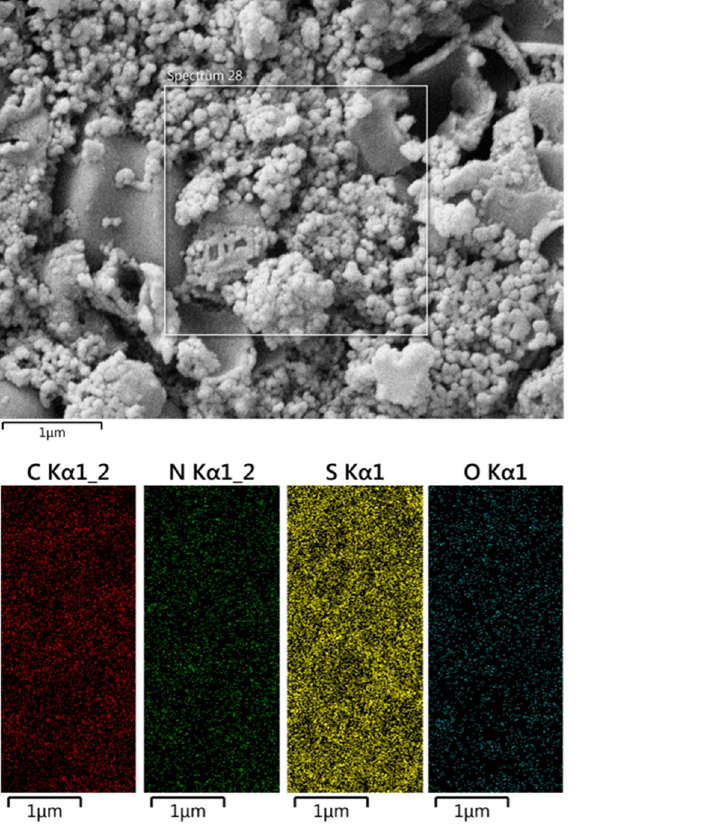
Figure 4. EDX elemental mapping of (N,